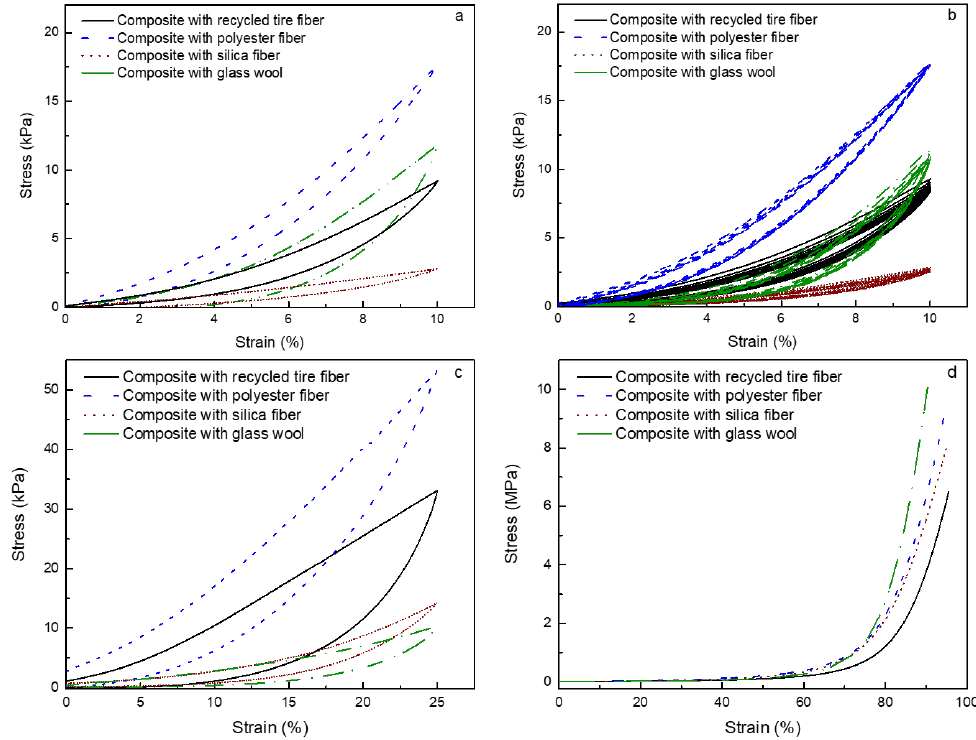
Figure 7. Mechanical behavior of the rubber-silica aerogel composites reinforced with different fi- bers. ( a ) Reversible compressive stress-strain curves of the composites until 10% strain and ( b ) ten cycles of reversible compressive stress-strain curves of the composites until 10% strain; ( c ) reversible compressive stress-strain curves of the composites until 25% strain, all with a load cell of 50 N; ( d ) uniaxial compression with a load cell of 3 kN.